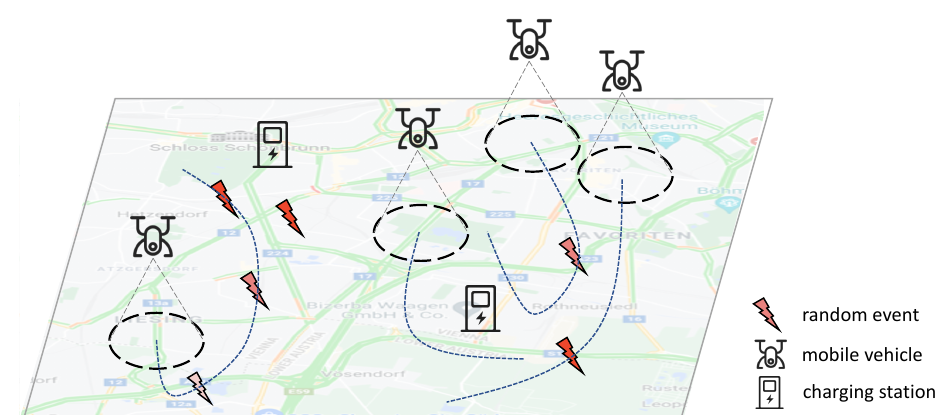
Figure 1. An illustration of the mobile sensing, where multiple vehicles cooperate to monitor the random events. The blue dash lines represent the moving trajectory of each vehicle. Events with a redder color imply higher